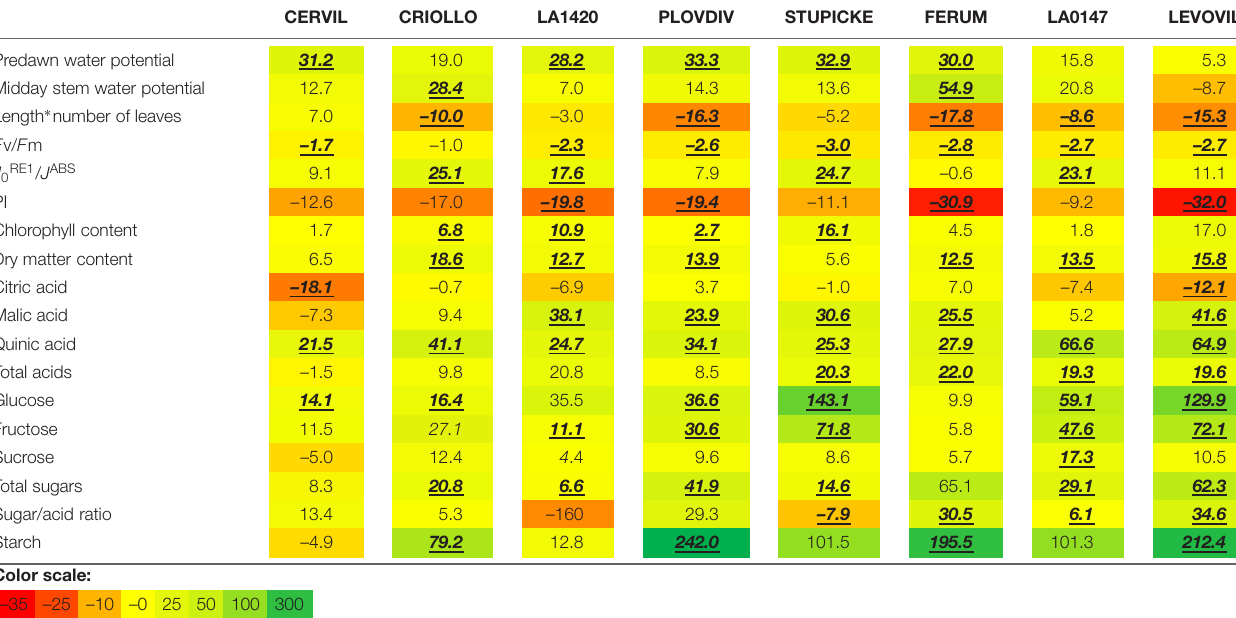
TABLE 2 | Relative differences in plant and leaf traits between the WD treatments and the control.